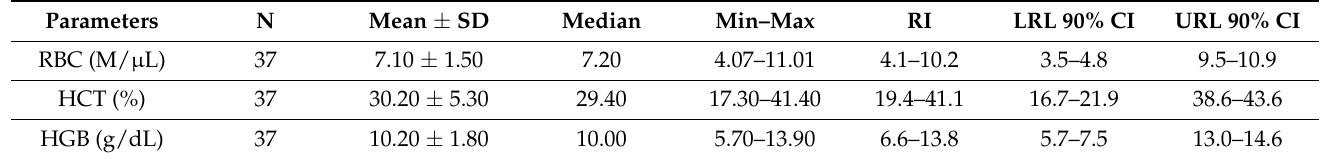
Table 1. Reference intervals of hematological parameters in 37 healthy animals of the species Erinaceus europaeus